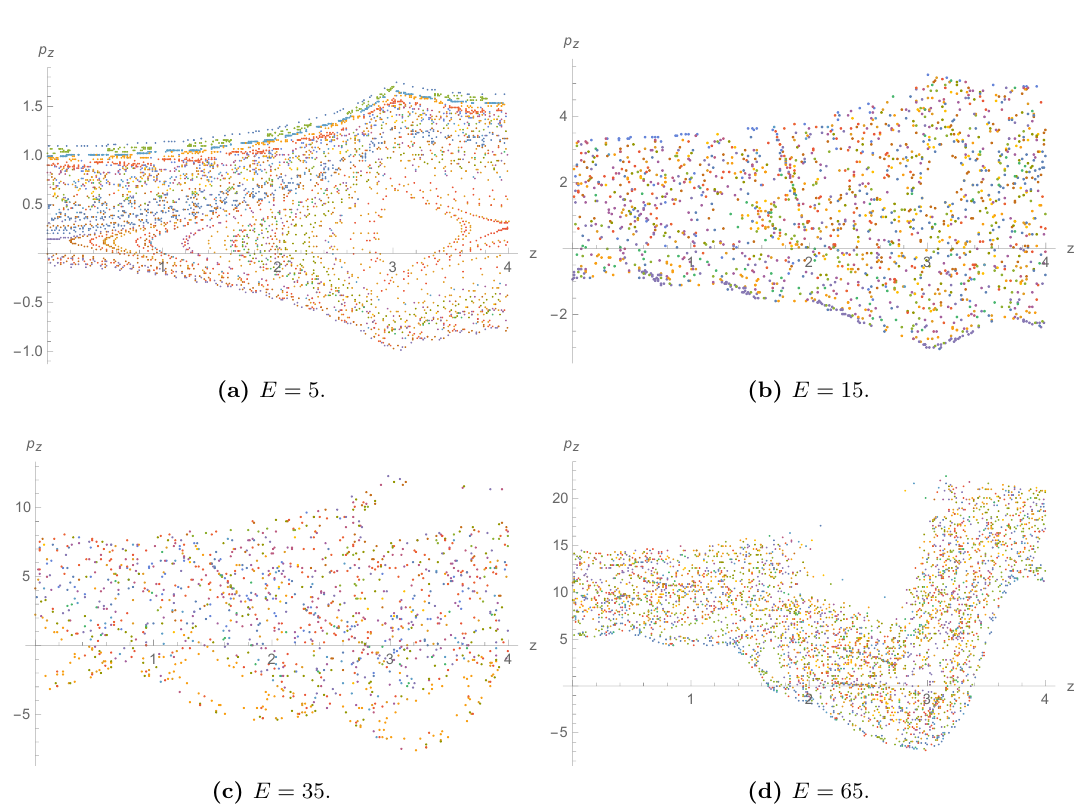
Figure 14. Poincar(cid:19)e sections for the ( z; p z )-plane at (cid:31) ( t ) = 0, for the quiver in eq. (2.6) at di(cid:11)erent energies.